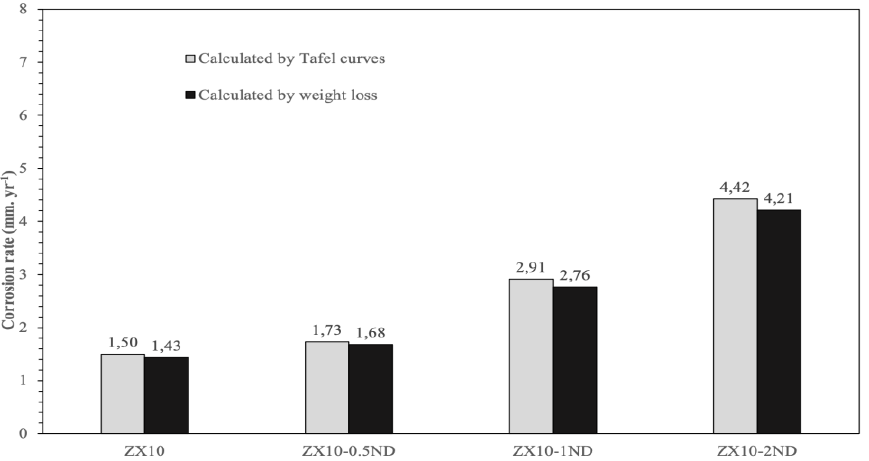
Figure 14. The average corrosion rates of the ZX10 alloy and ZX10-0.5ND, ZX10-1ND, and ZX10-2ND nanocomposites.